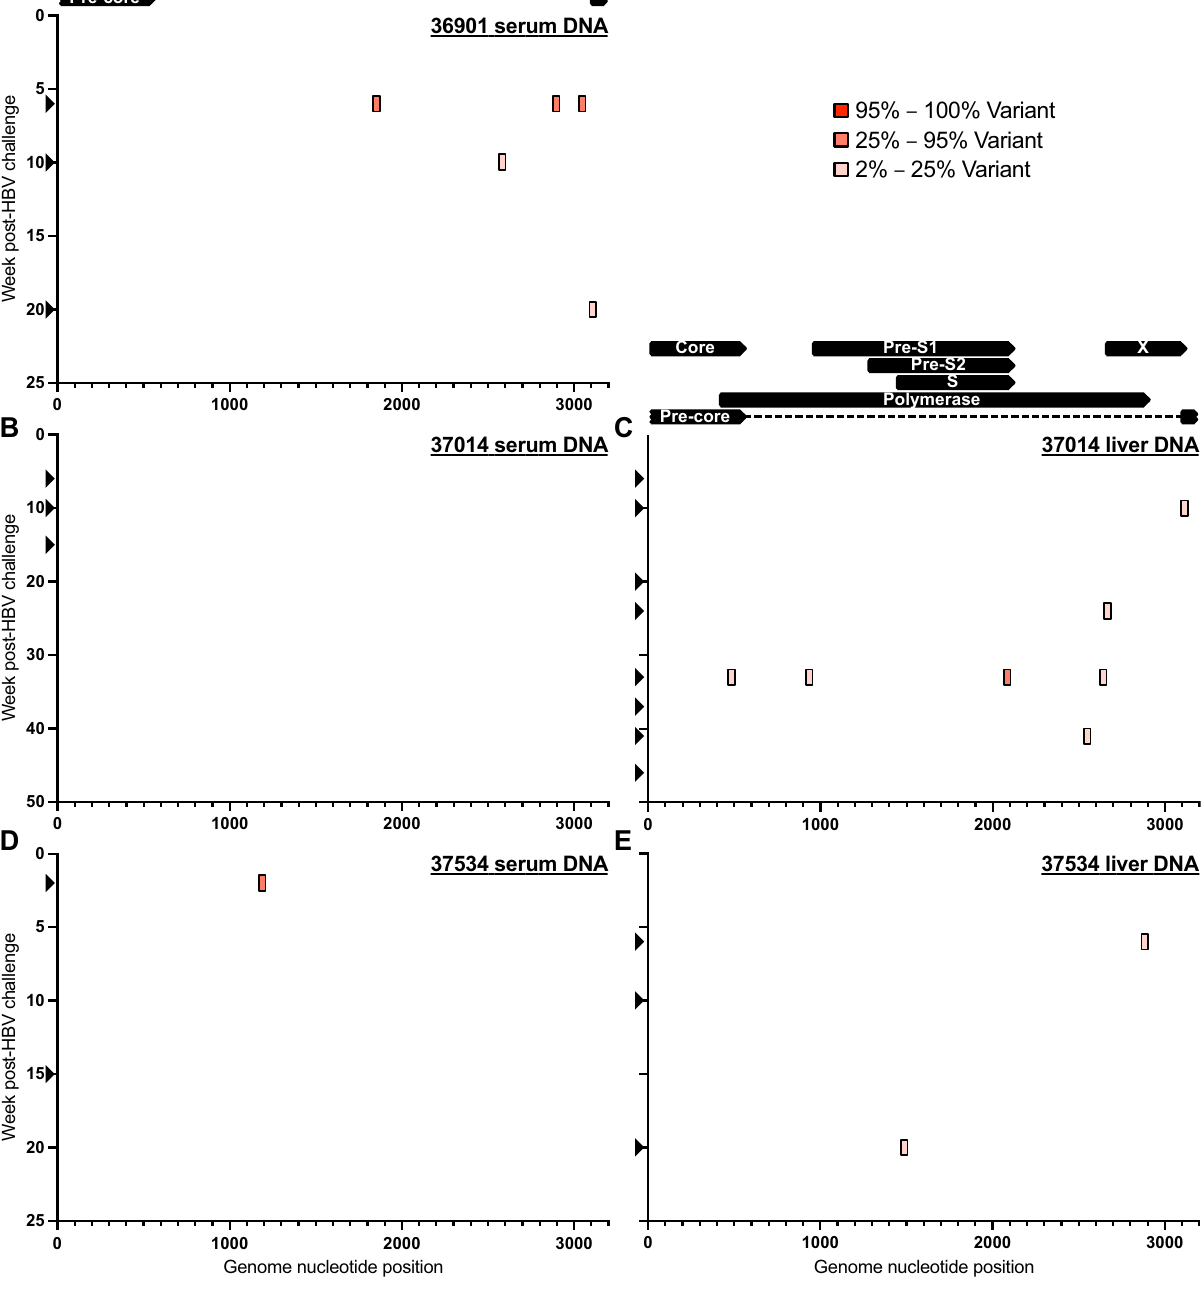
Fig. 5 HBV sequencing of serum and liver DNA from HBV-infected RM. Shows genetic variation (single nucleotide polymorphisms) across the HBV genome (position 1 is start codon of HBV core ORF). Black arrows on y-axes indicate time points sequenced. Source data are provided as a Source Data fi including during immunosuppression and peak viral replication (black arrows on y-axes, Fig. 5). RM 36901 harbored three intermediate frequency variants (25 – 95% of reads) at 6 wpi in serum-derived HBV (Fig. 5A). The variant at position 1855 (40%) was synonymous in the Pol open reading frame (ORF), but nonsynonymous in the Pre-S1/S2/S ORF (T80I). In addition, the variant at position 2895 (40.4%) was synonymous in the X ORF, ingly, we found little to no genetic variation in the serum or liver but nonsynonymous in the Pol ORF (K810R). The fi nal variant at samples from the three infected RMs across multiple time points, position 3048 (41.3%) was synonymous in the X ORF.